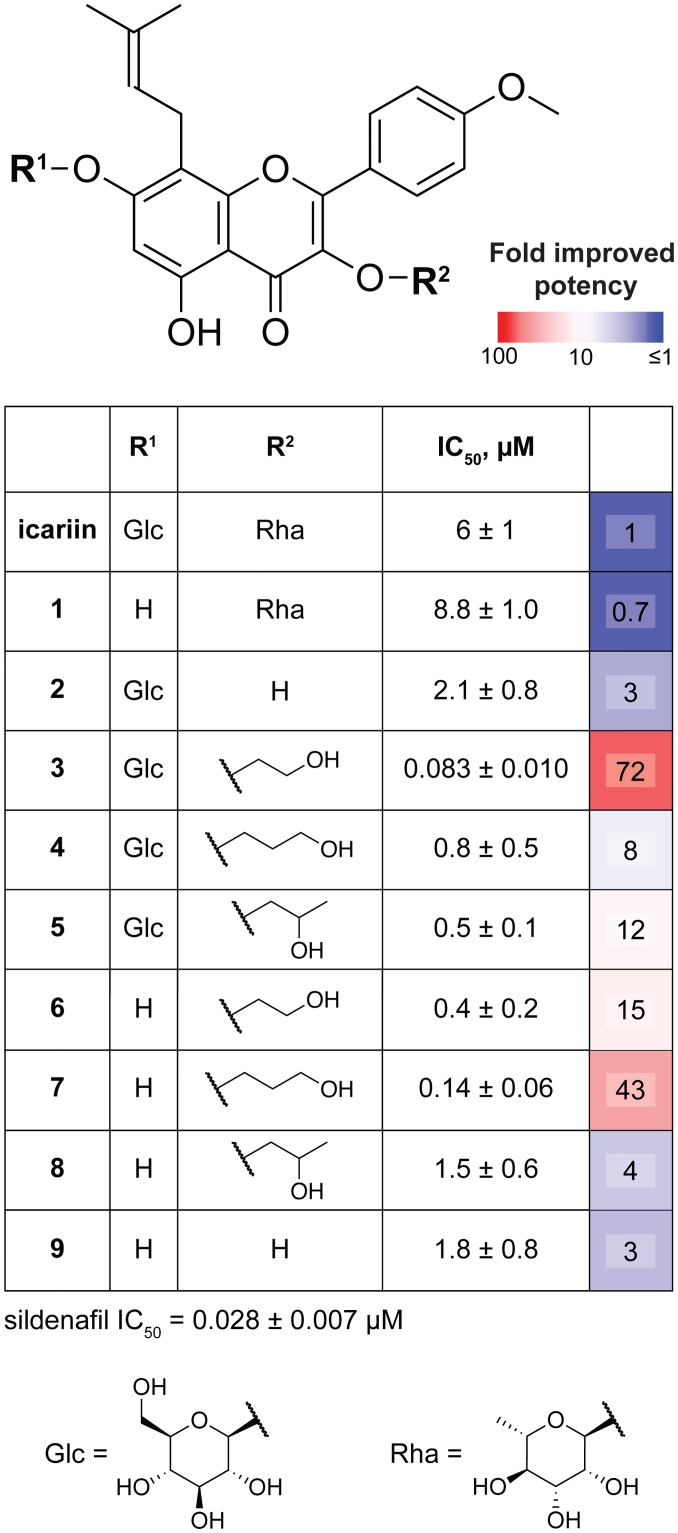
The 3-O and 7-O positions of icariin pharmacophore act synergistically to influence icariin analog PDE5 inhibition.IC50 values for icariin and icariin analogs 1–9 were obtained via in vitro inhibition assays using purified recombinant human PDE5. IC50 values represent mean (of at least three replicates) ± SEM. Fold improved potency refers to fold change in IC50 compared to icariin.